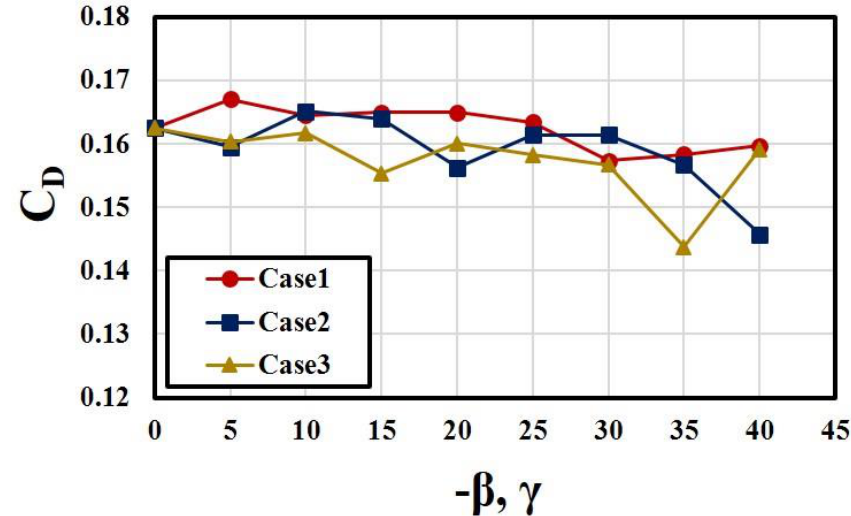
Figure 7. Variations of drag coefficient with pitch and/or bending angles of fluidic oscillators (α = 8°, δ f = 40°, C μ = 2.64%).